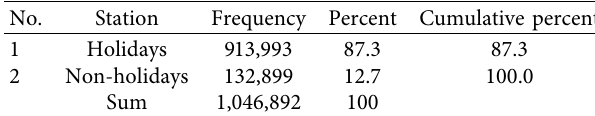
Table 6: Percentage of holidays in this